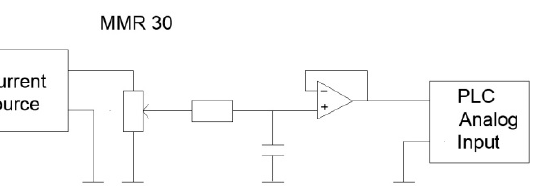
Figure 6. Diagram of the processing path of the measurement system d (d —the distance between the lens and the observed object).